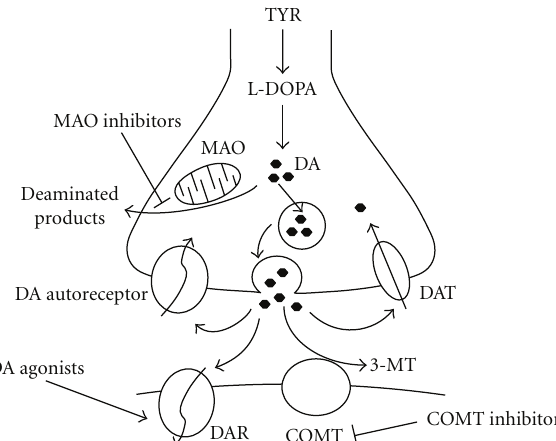
Figure 1: Treatment of Parkinson’s disease: anti-Parkinson’s medications modulate key stages of dopaminergic